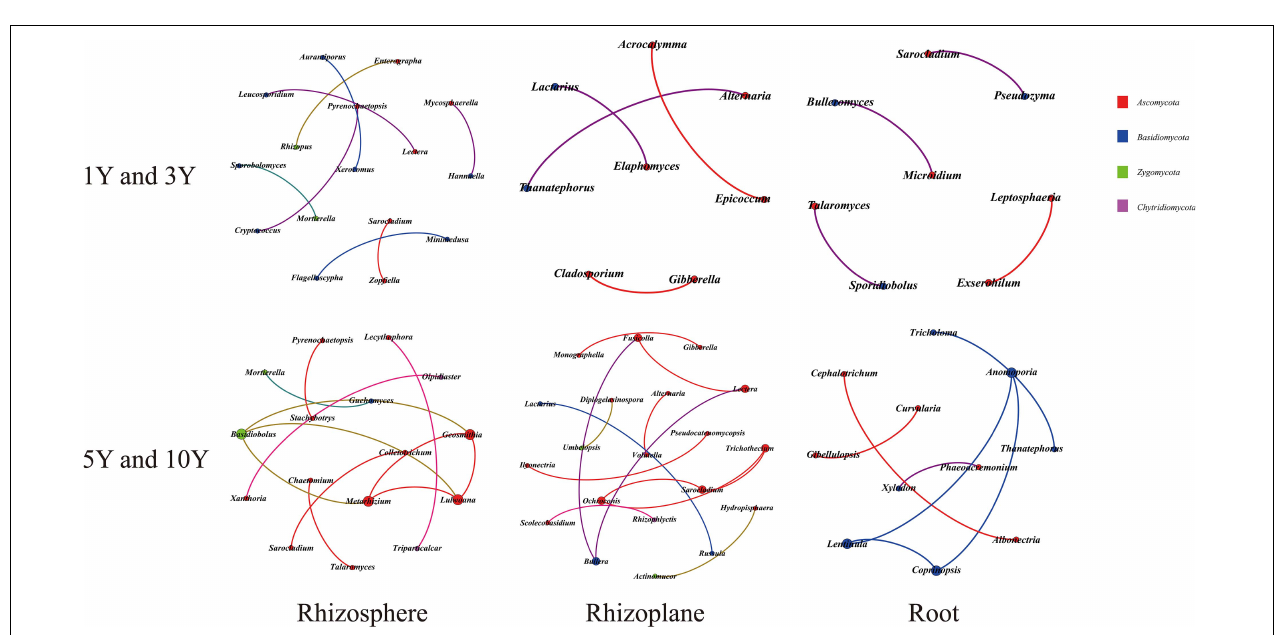
FIGURE 3 | The co-occurrence network of bacterial genera based on correlation analysis for different samples in three root-associated compartments. A connection stands for a strong (Spearman’s r > 0.6) and significant ( p < 0.01) correlation. The size of each node is proportional to the degree. Nodes colored by taxonomy.